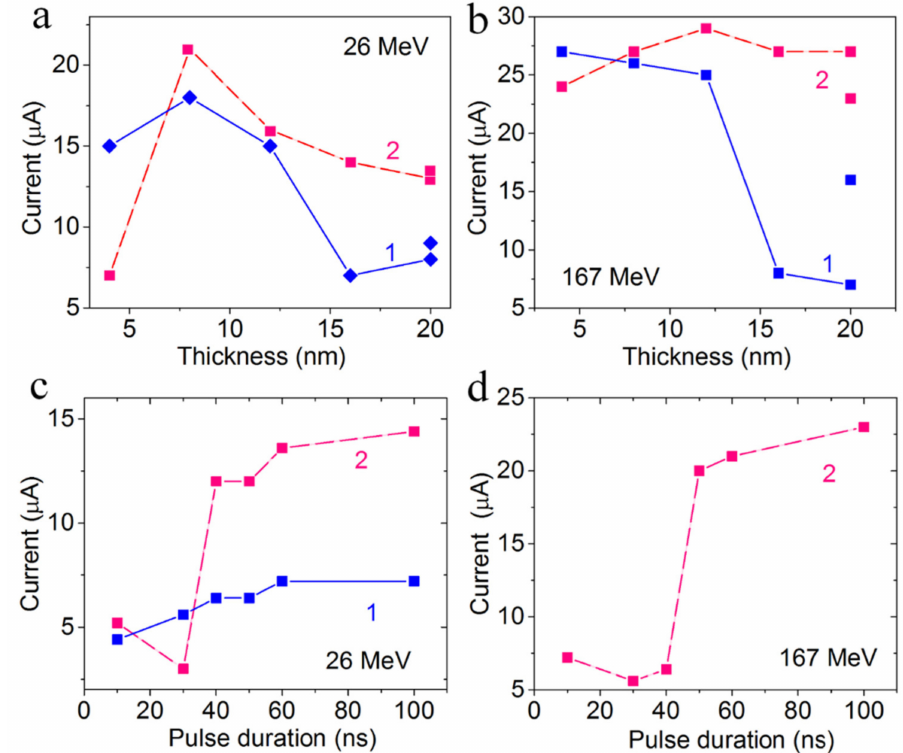
Figure 8. ( a , b ) Current in the memristive structures in the open state as a function of the FG layer thickness for irradiation with different Xe ion energies: ( c , d ) Open-state current versus opening pulse duration for the structures with the FG thickness of ( c ) 10–12 nm and ( d ) 17–20 nm. The irradiation regimes are as follows: the energies were ( a , c ) 26 MeV and ( b , d ) 167 MeV, the fluences were: 1–3 × 10 10 cm − 2 , 2–3 × 10 11 cm − 2 . The voltage pulse is 2.5